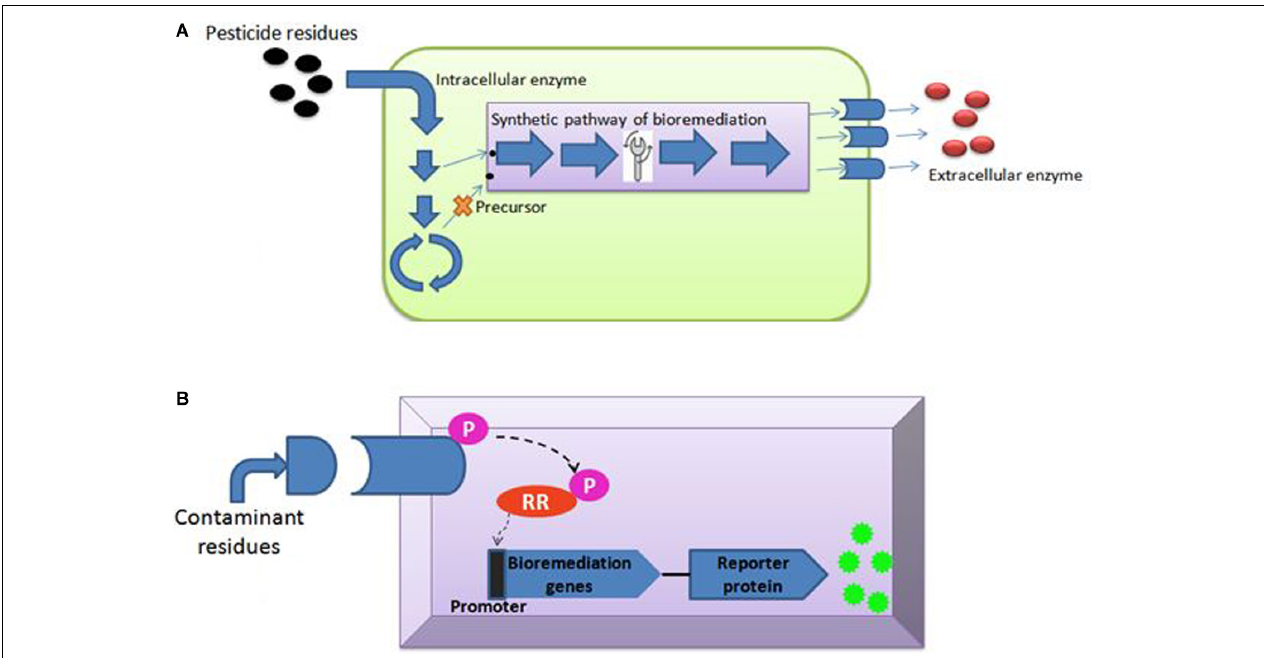
FIGURE 3 | Schematic presentation (A) intracellular and extracellular enzymes production; (B) TCRS based